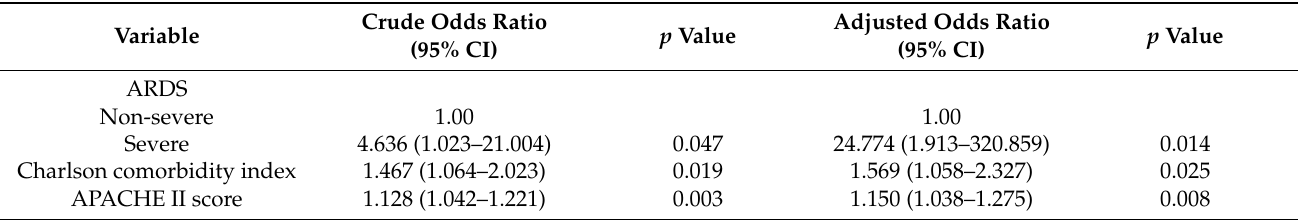
Table 4. Risk factors for mortality in ICU patients with coinfection of influenza and aspergillosis (group 1) using multivariate regression analysis.